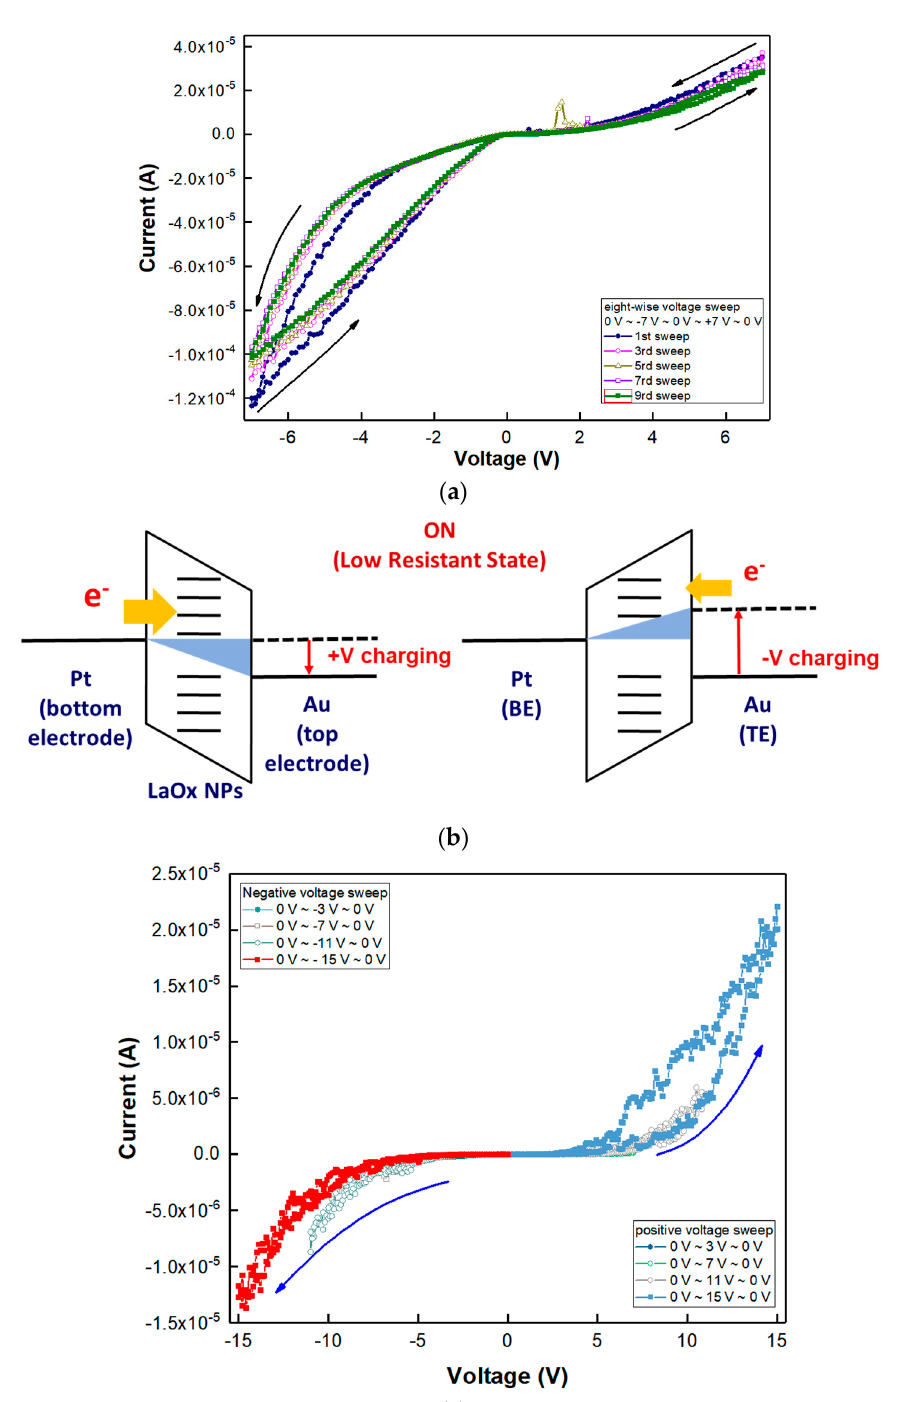
sweeps of 0 V → +1.5 V → 0 V for successive ten times in Figure S2. As shown in Figure S2, no apparent hysteresis similar to Figure 3a was observed with the Al top electrode.